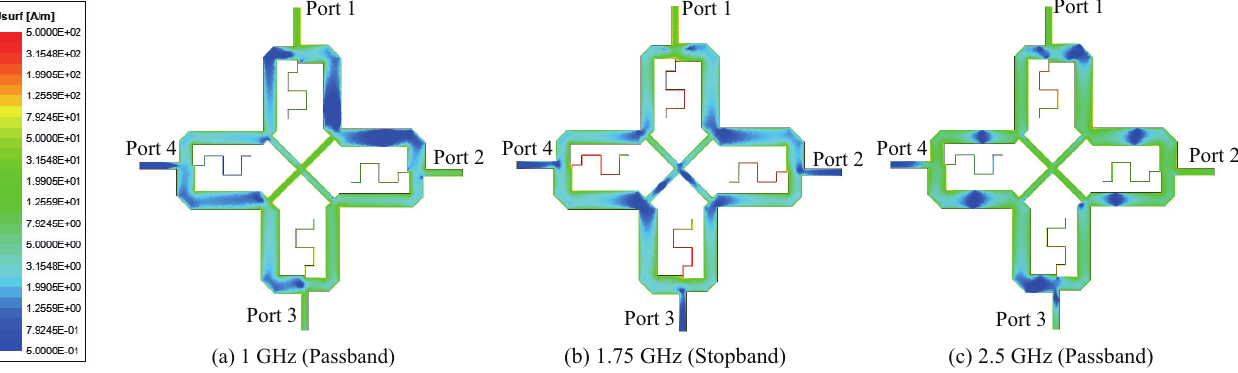
Figure 8. Current distribution of Coupler B ( k 1 = − 3 dB and k 2 = + 3 dB).